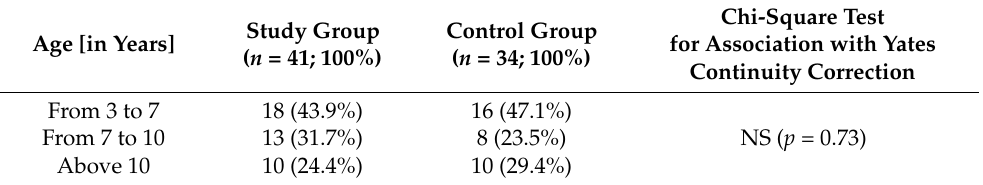
Table 2. Distribution of age in the study group and the control Table 1. Distribution of sex in the study group and the control group.